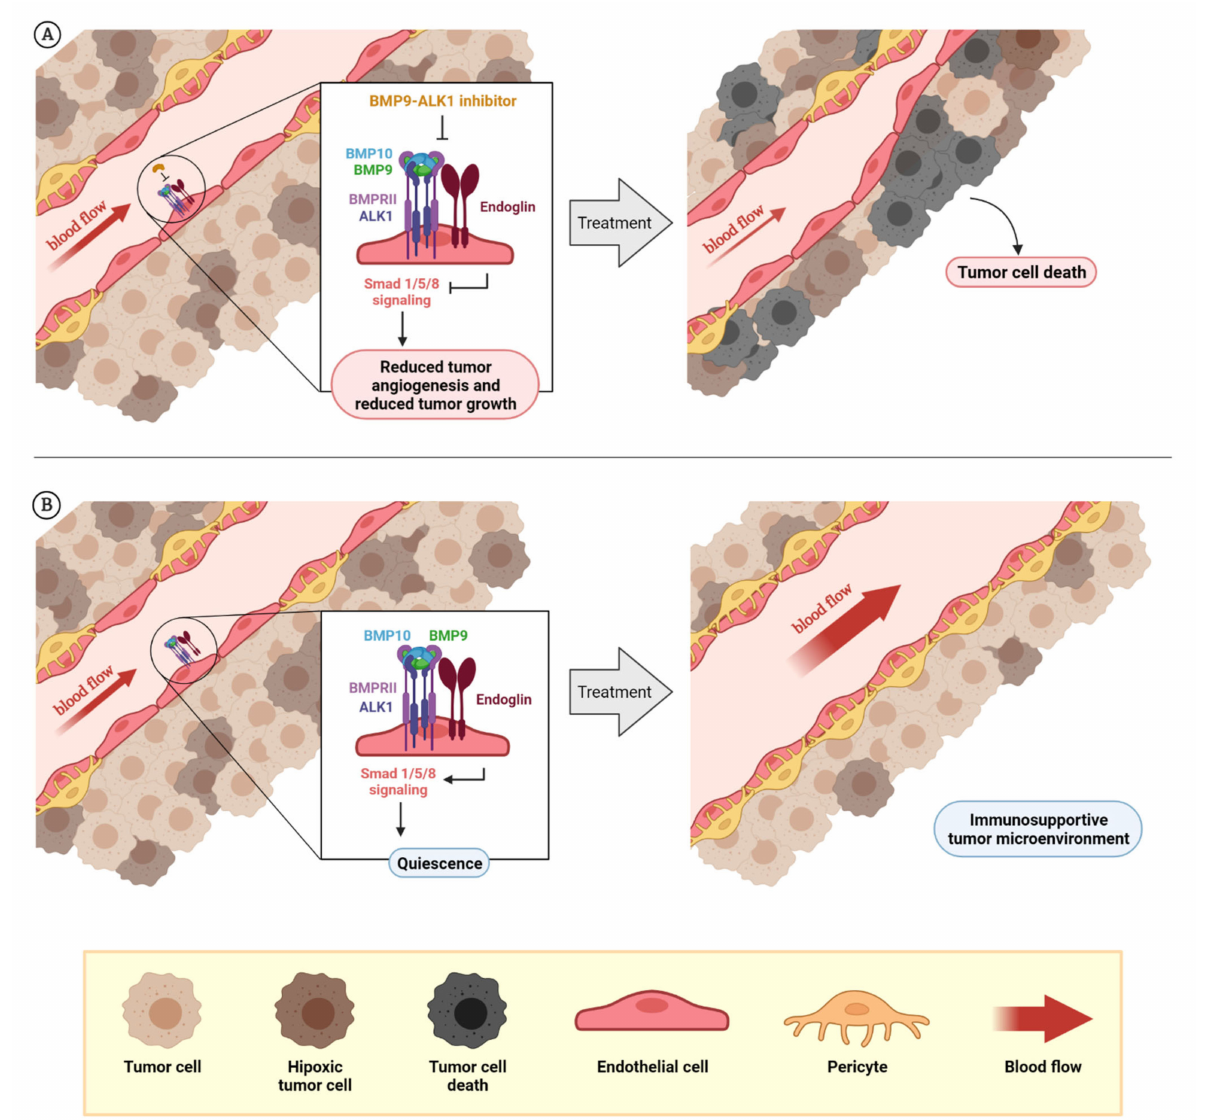
Figure 3. Rationale for the design of BMP9–ALK1-based therapies . The dual role of BMP9–ALK1 in endothelial balance can be used for different therapeutic approaches: the inhibition of tumor blood vessels in which ALK1 behaves as a pro-angiogenic receptor (BMP9 triggers its signaling through Smad1/5/8 and promotes the activation of angiogenesis) that can be used to reduce tumor angiogenesis and tumor growth, as has been demonstrated with molecules such as ALK1-Fc or PF-03446962. Additionally, as endoglin expression in endothelial cells potentiates BMP9-induced effects, blocking endoglin with molecules such as TRC105 can cause the same effects ( A ). On the other hand, considering blood vessels where the activity of the circulating factor BMP9 induces vessel quiescence through ALK1 receptor, the potentiation or mimicry of these effects can be used for vessel normalization with therapeutic purposes. Here is the opportunity to explore the effects on vascular normalization and creating a favorable tumor microenvironment of recombinant BMP9 administration or analogues ( B ). The composition of BMPRI (ALK1 or ALK5) and BMPRII receptor complexes and the levels of the ligands BMP9 and BMP10 seems to be very important to determine when ALK1 receptor induces the promotion of angiogenesis or vessel maturation. At the same time, the role of other factors such as TGF- β 1 or sEng, which can block BMP9 binding, needs to be further studied. Created by BioRender.com, accessed on 17 October